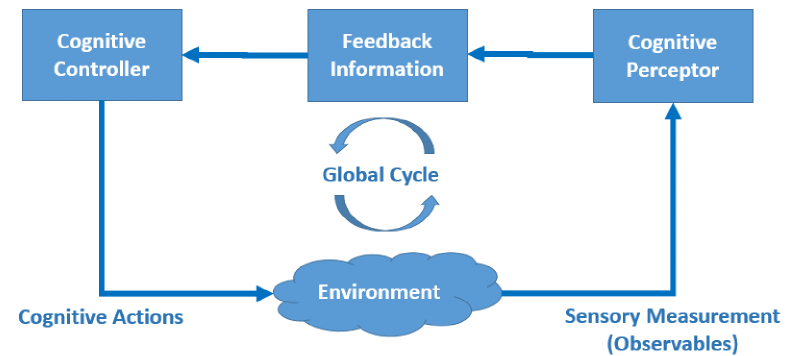
Figure 2. Cognitive Dynamic System (CDS) expressed as a Global Perception-Action